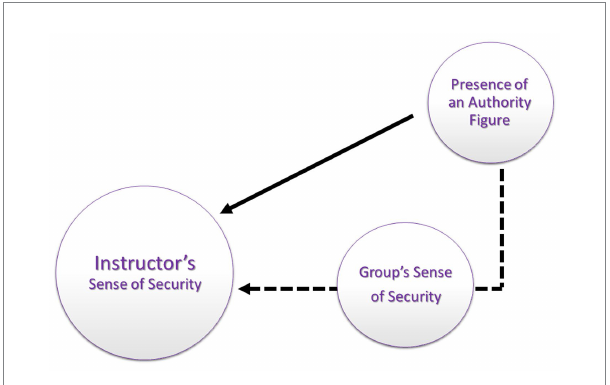
FIGURE 3 SBL instructors’ second level of MHN: Security Needs. The assumed paths thorough which the authority figure influences on the instructor’s sense of security, as emerged from the instructors’ reports of their sense of security: directly (represented by bold line) and indirectly (represented by broken